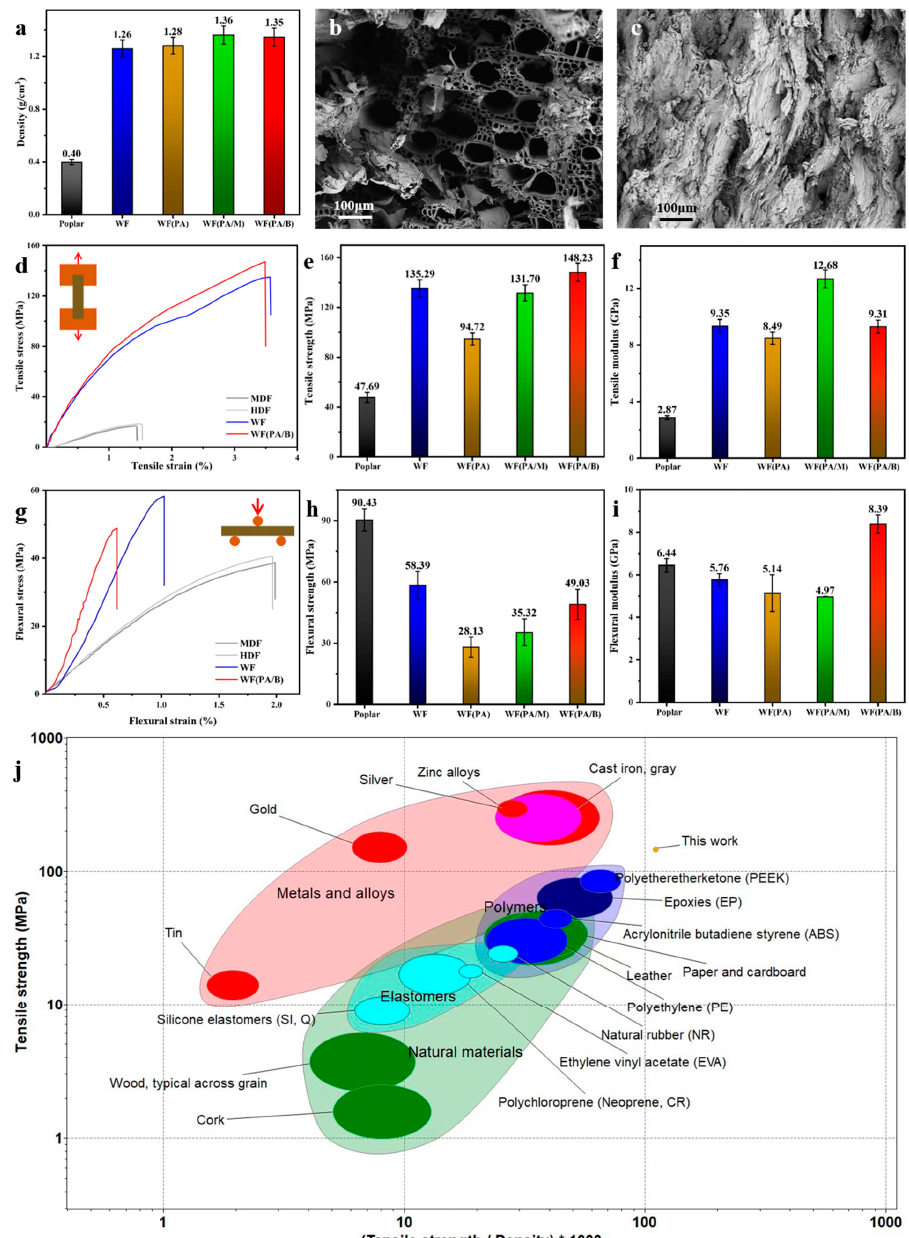
Figure 2. ( a ) Densities of raw material (poplar) and product (biocomposites). ( b ) Cross-section images of the raw material. ( c ) Cross-section images of the best product (WF(PA/B)). ( d – f ) Tensile stress–strain curves, tensile strengths, and modulus of samples. ( g – i ) Flexural stress–strain curves, flexural strength, and modulus of samples. ( j ) Comparison of several common products and biomaterials with respect to tensile and specific